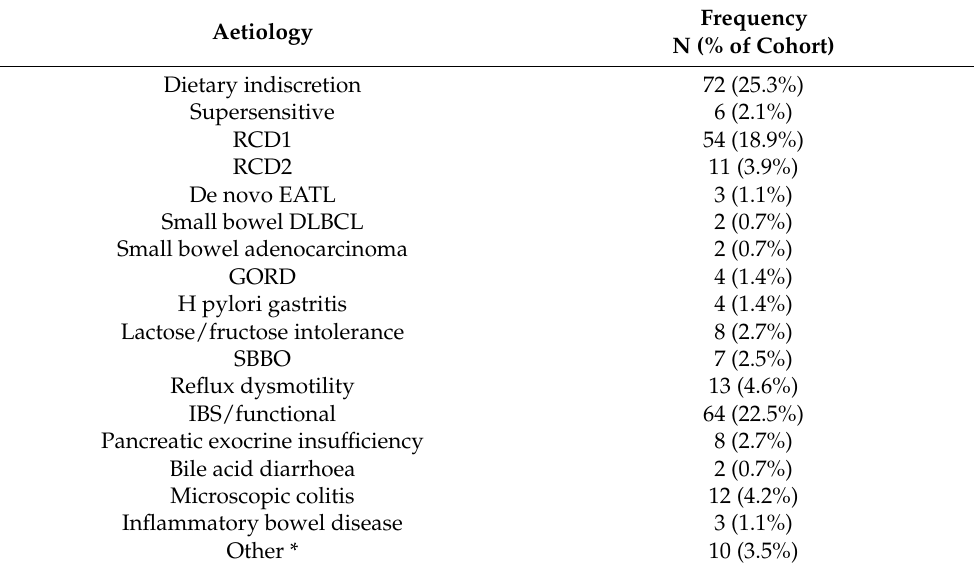
Table 1. The causes of NRCD in patients with established